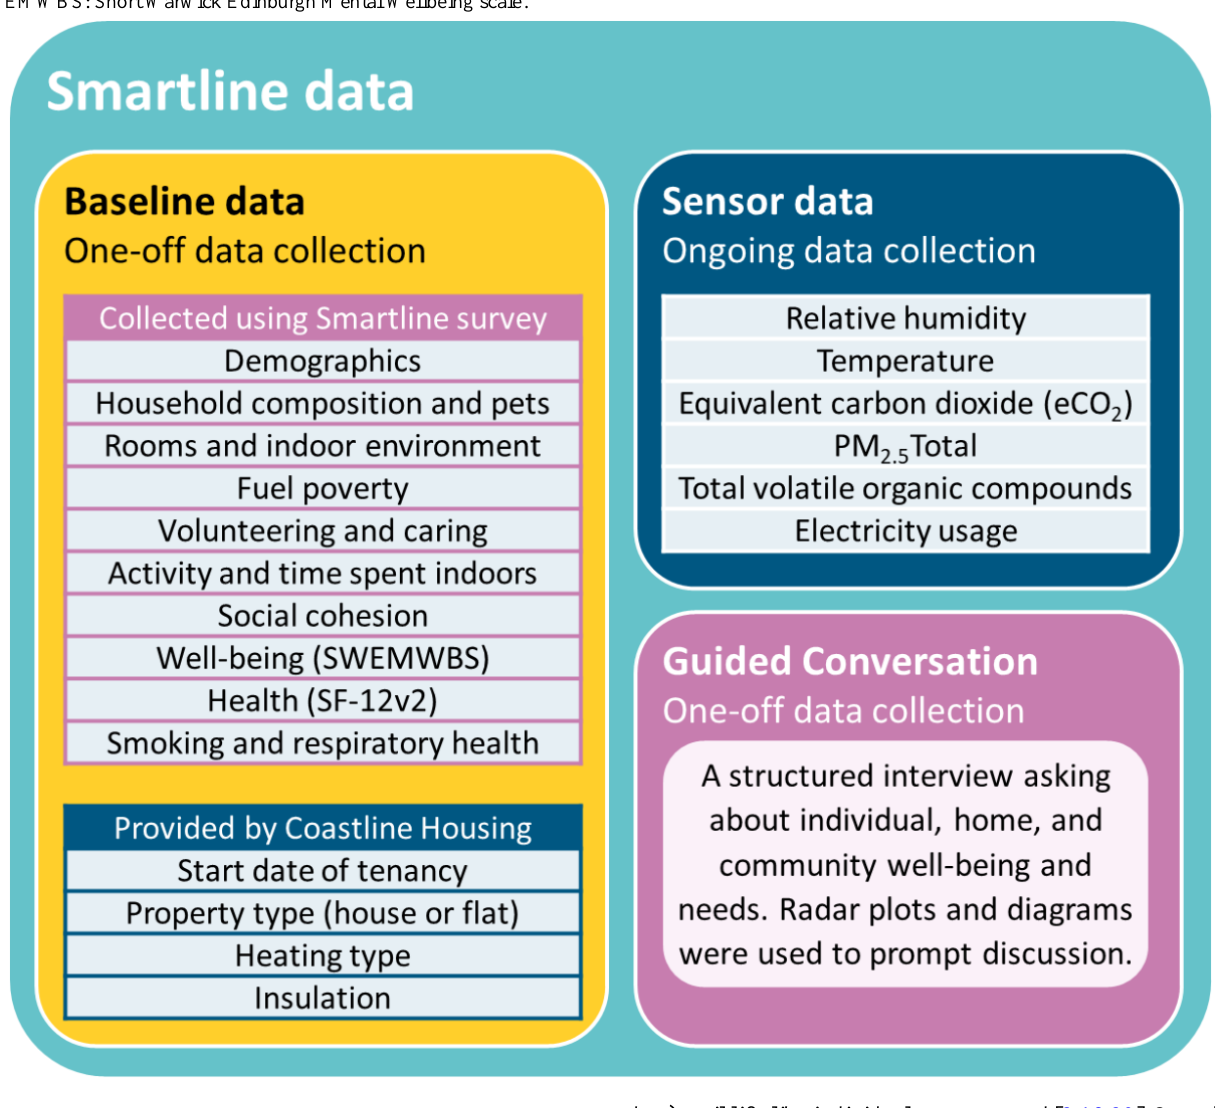
Figure 1. Smartline project data sets. eCO 2 : equivalent carbon dioxide; PM 2.5 : atmospheric particulate matter that have a diameter of less than 2.5 m; SWEMWBS: Short Warwick Edinburgh Mental Wellbeing